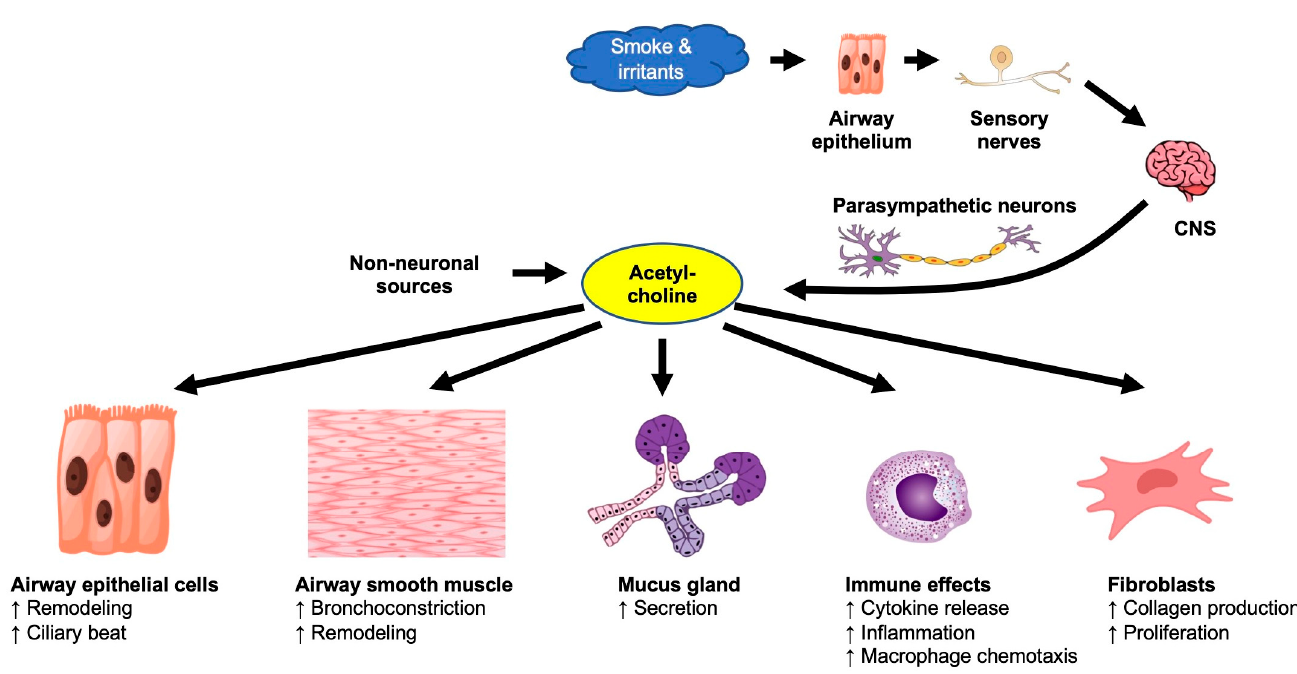
Figure 1. Acetylcholine in the pathogenesis of COPD. Adapted from Buels et al. 2012 [15], Kummer et al. 2008 [16], and Kolahian et al. 2012